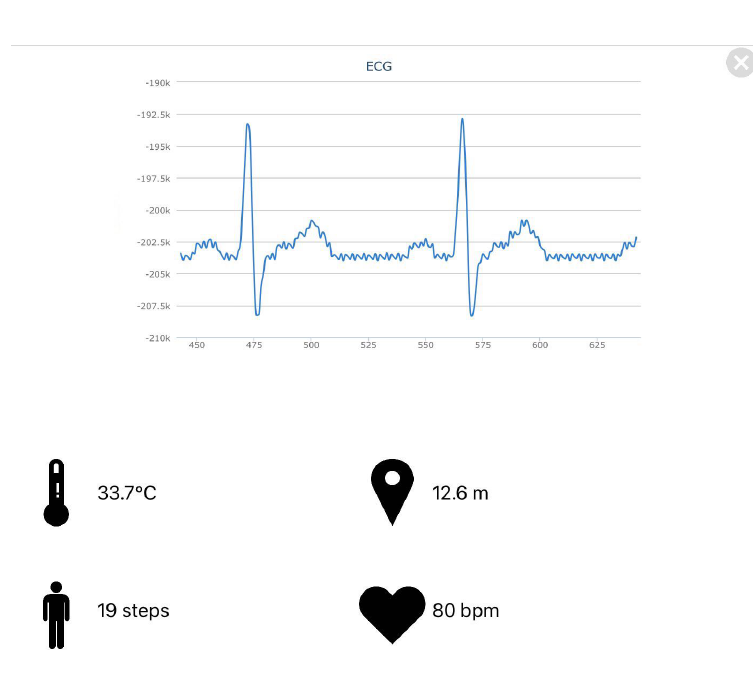
Figure 6. User interface on a mobile